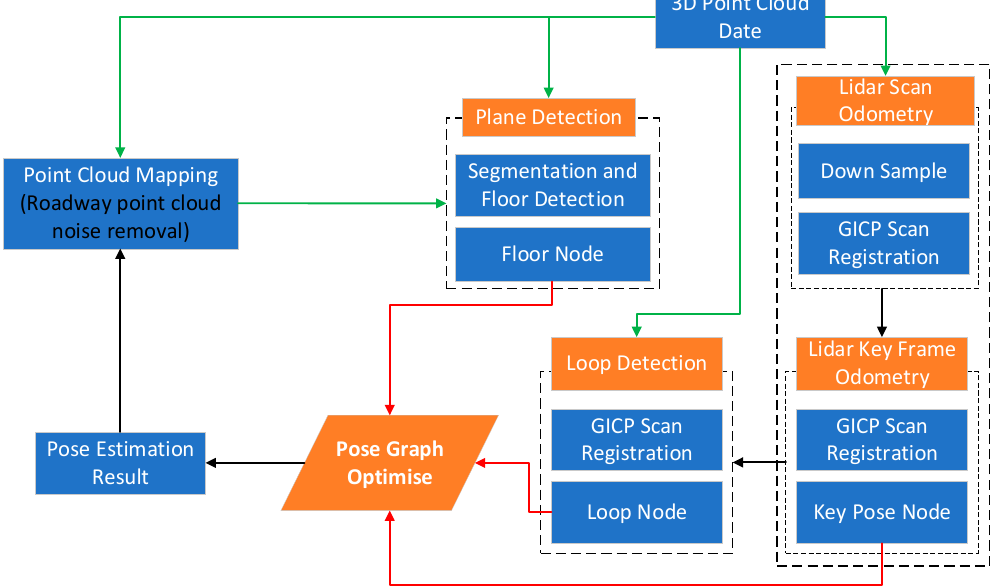
Figure 1. Generalized Iterative Closest/Corresponding Point (GICP)- simultaneous localization and mapping (SLAM) system framework.